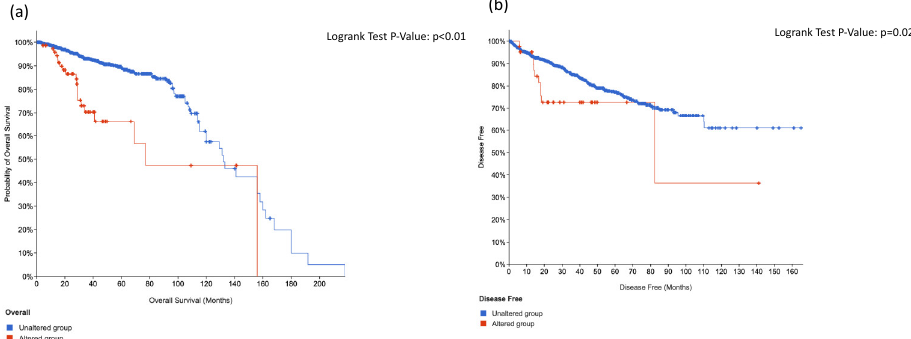
Figure 2. KIT , HRAS and CTNNB1 combination score prognosis in prostate cancer for overall survival ( a ) and disease-free survival ( b ).